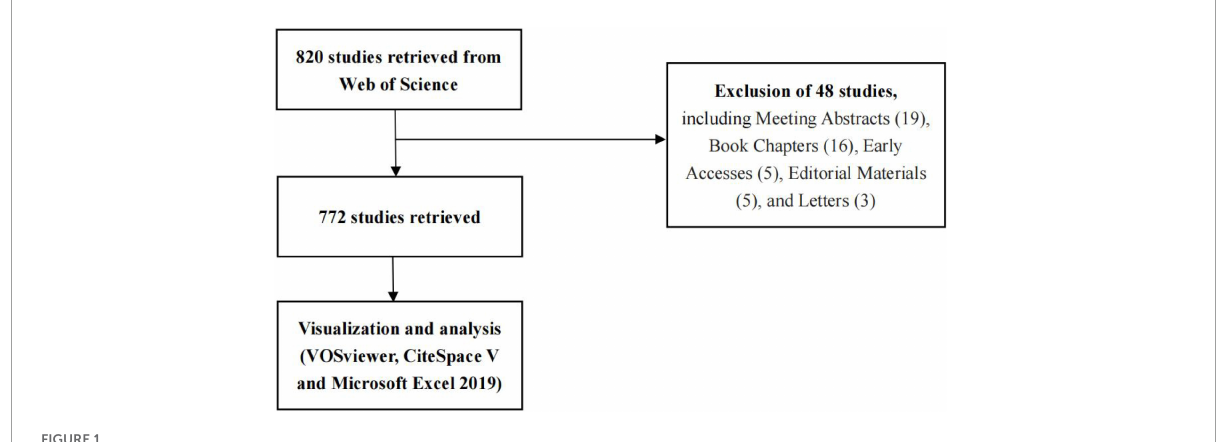
FIGURE1 Literature screening for exosome studies in platelet.